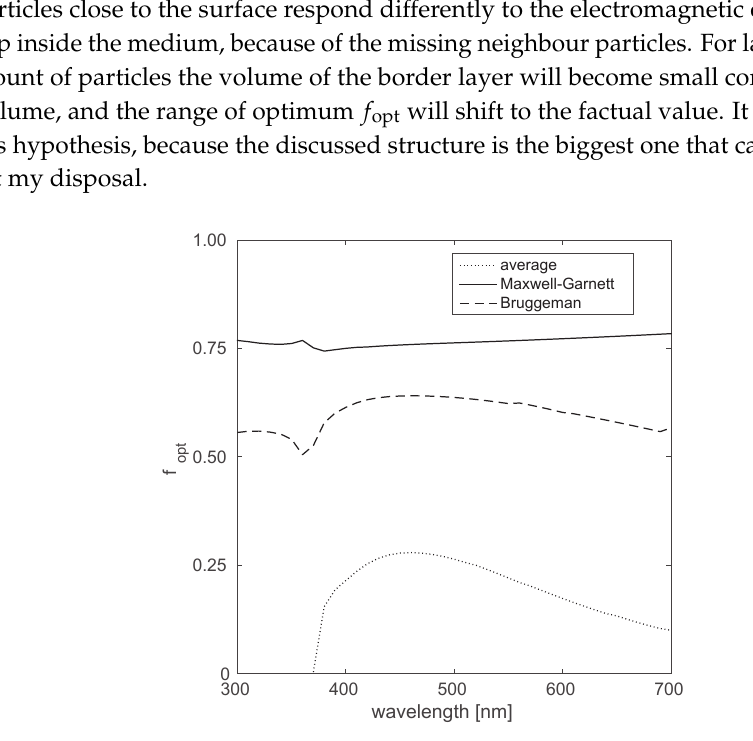
Figure 3. Optimum filling fraction f to match the T-matrix extinction spectrum.